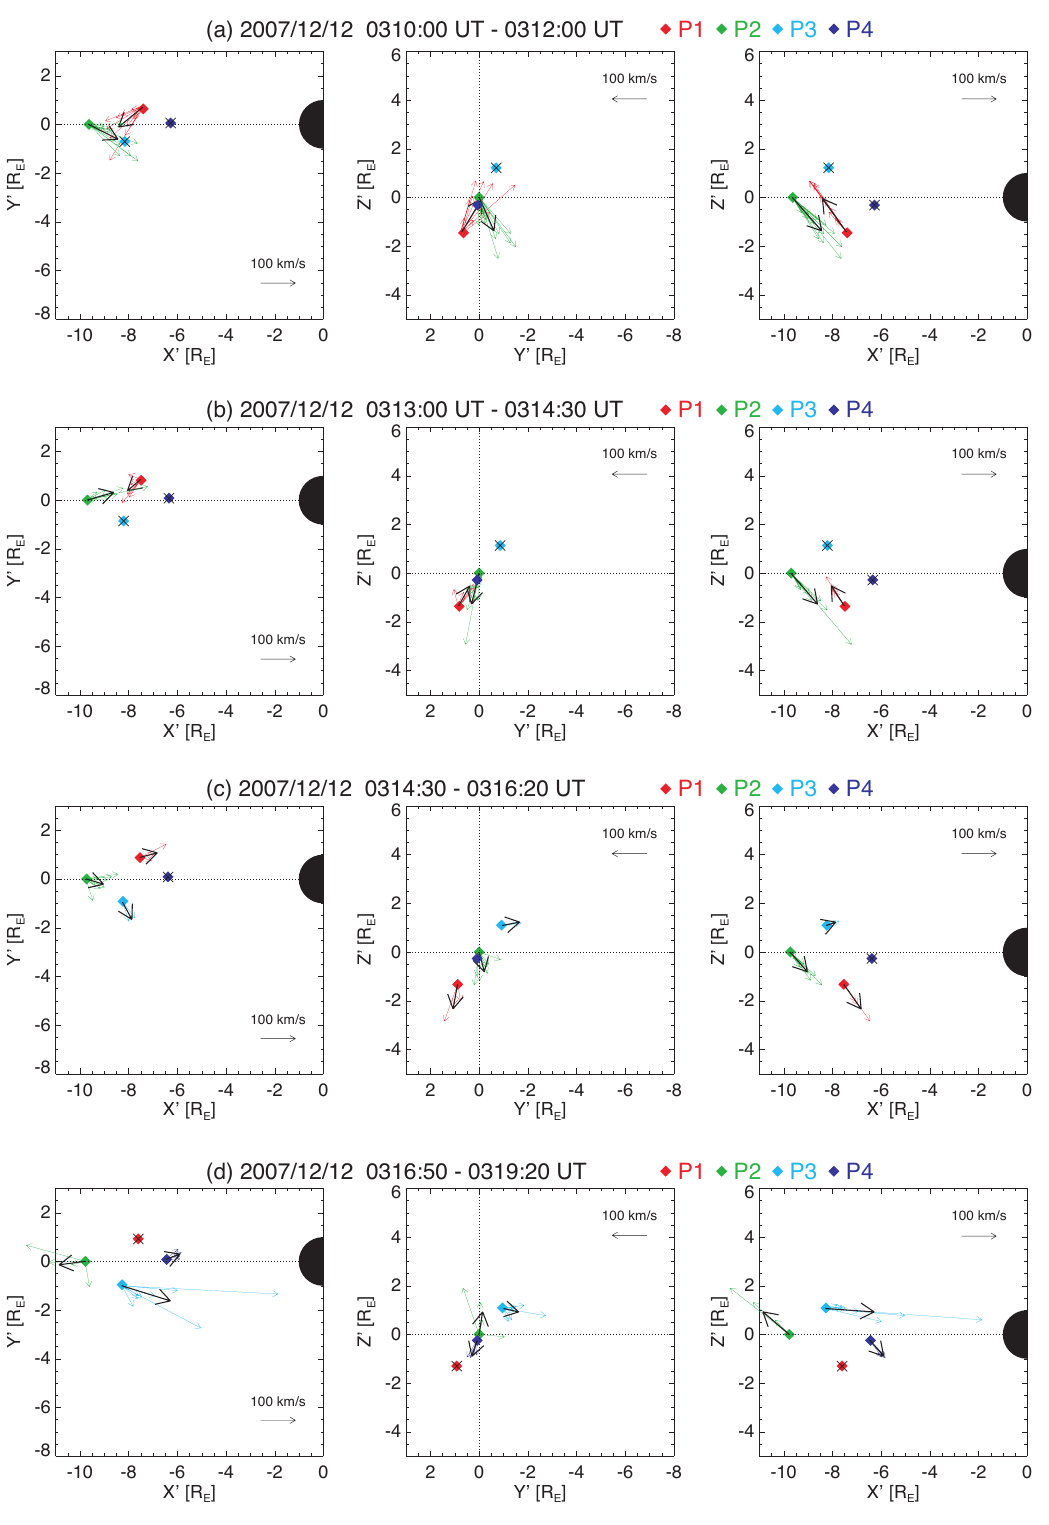
Fig. 4. Plasma flow patterns during the four intervals indicated by the red and blue shadows in Fig. 3 in the X 0 − Y 0 (left), Y 0 − Z 0 (right), and X 0 − Z 0 planes of the new coordinate system. Diamonds represent spacecraft positions and thin arrows indicate flow direction and strength. Each thick arrow shows an average of fast flows indicated by the corresponding thin arrows. “X” signs denote no clear flow